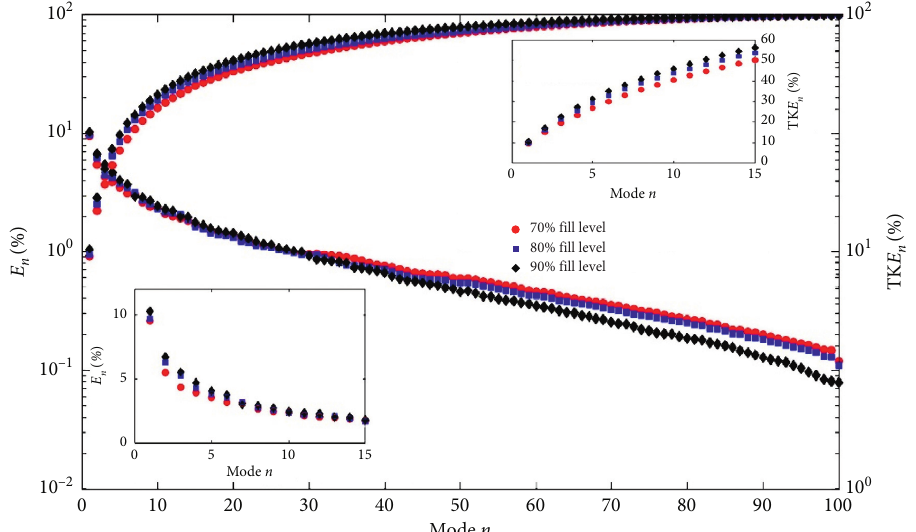
Figure 7: Energy distribution of POD modes at different oscillation accelerations under 70% fill